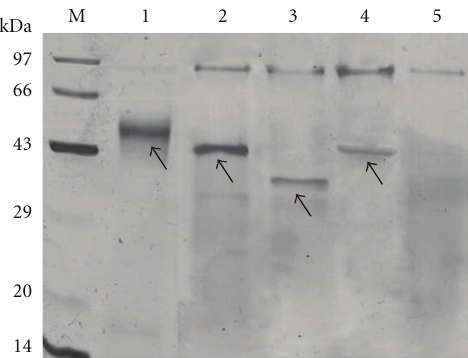
Figure 4: SDS-PAGE analysis of Pichia derived native rPA and its mutants. M: Medium protein molecular weight marker (97 to 14 kDa); lane 1: native rPA ( ∼ 55kDa); lane 2: (N12P mutant ∼ 43kDa); lane 4: (N12P, N278S mutant, ∼ 39 kDa); lane 4: (N278S, ∼ 43kDa) lane 5: GS115 control.